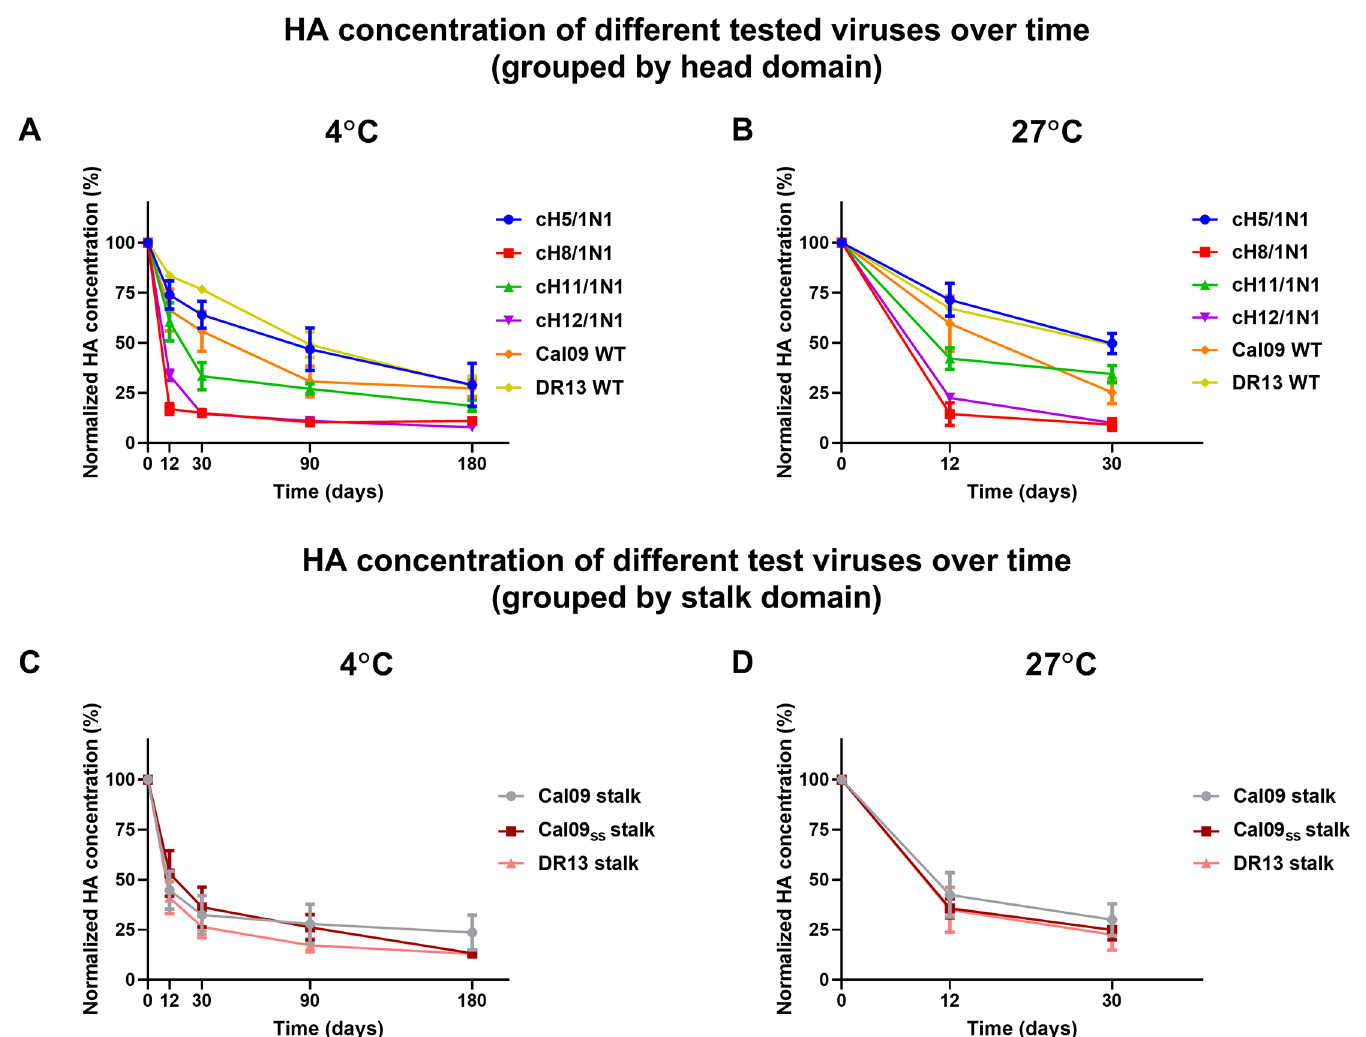
Fig 4. Stalk stability under different storage conditions. HA content of crude cH5/1N1, cH8/1N1, cH11/1N1, cH12/1N1, wild type Cal09 and wild type DR13 preparations at 4˚C and 27˚C. The HA content of samples stored at 4˚C was measured on days 0, 12, 30, 90 and 180; and HA content of samples stored at 27˚C was measured on days 0, 12 and 30. In order to better understand the effects of the storage conditions on the stability of the two main HA domains (head and stalk), viruses were grouped based on either (A, B) head domain or (C, D) stalk domains. Data points in A and B represent an average of two replicates for the wild type strains and an average of three viruses (Cal09, Cal09ss, DR13) for cHA strains, while the data points in C and D represent an average of five viruses (cH5/1N1, cH8/1N1, cH11/1N1, cH12/1N1 and wild type) for Cal09 and DR13 stalk viruses and four viruses (cH5/1N1, cH8/1N1, cH11/1N1, cH12/1N1) for the Cal09ss stalk. The error bars represent the standard error of mean. All HA concentrations were normalized to concentrations measured on day